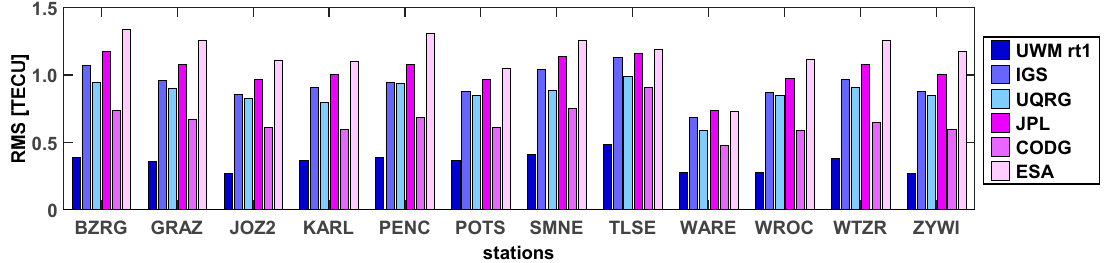
Figure 8. Average RMS based on all days and satellite arcs for selected test stations.